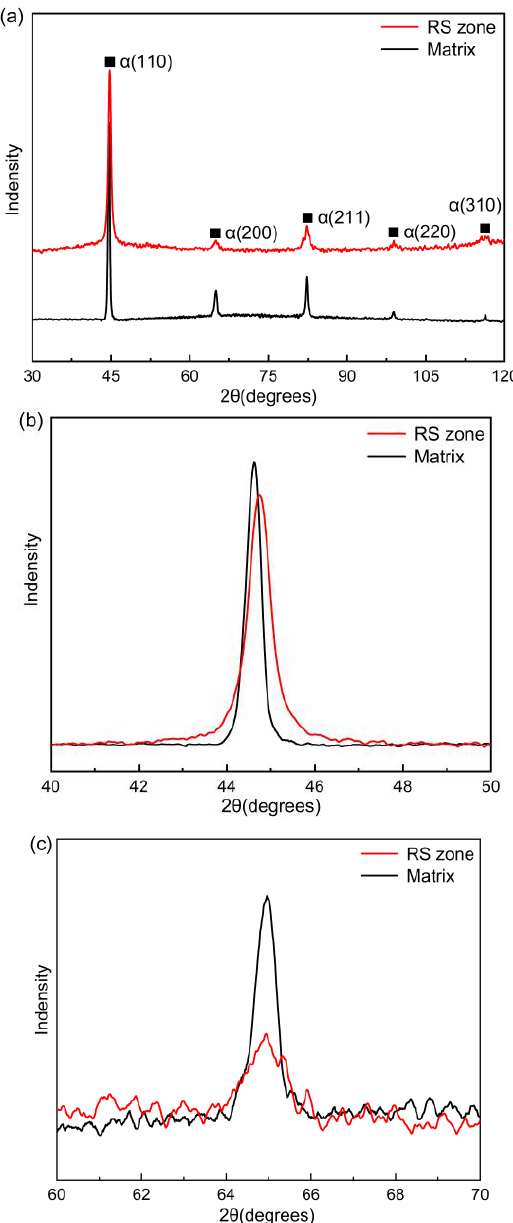
Figure 9. X-ray diffraction image of test steel: ( a ) RS zone and matrix; ( b ) (110) diffraction peak; ( c ) (200) diffraction peak.